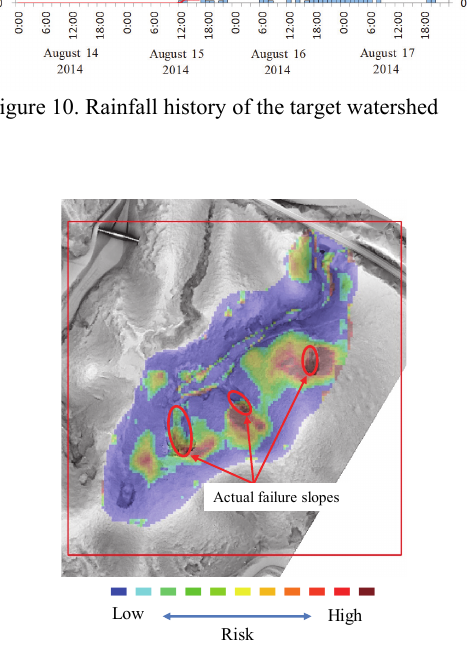
Figure 11. Slope failure risk estimated by the model, considering soil conservation by root